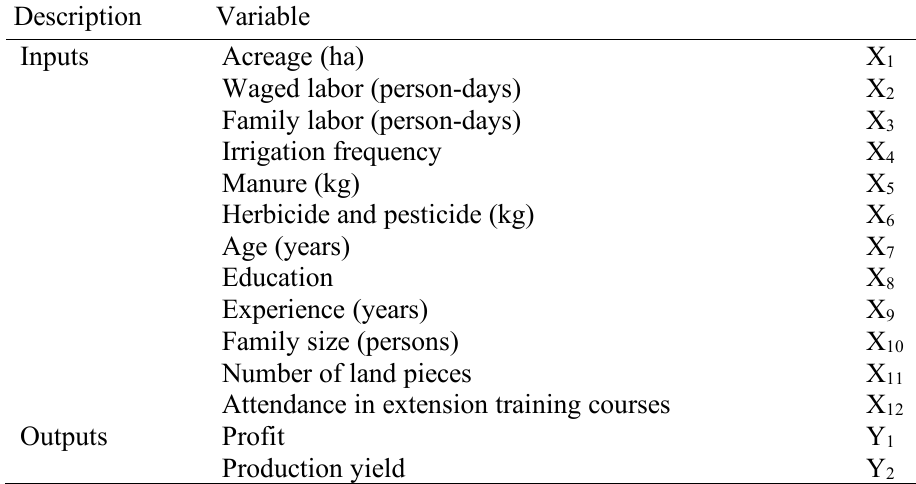
Table 2. Inputs and outputs of window analysis model and Malmquist productivity index